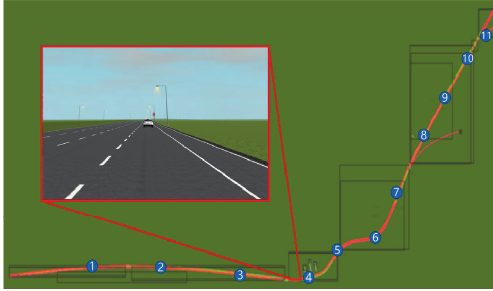
Figure 3: Interface